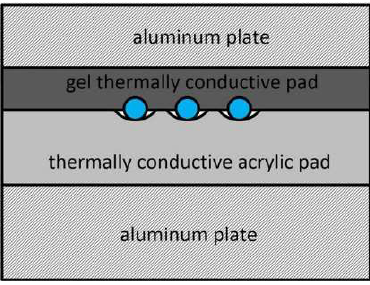
Figure 5. Cooling scheme of the active fiber of the third MOPA system stage.